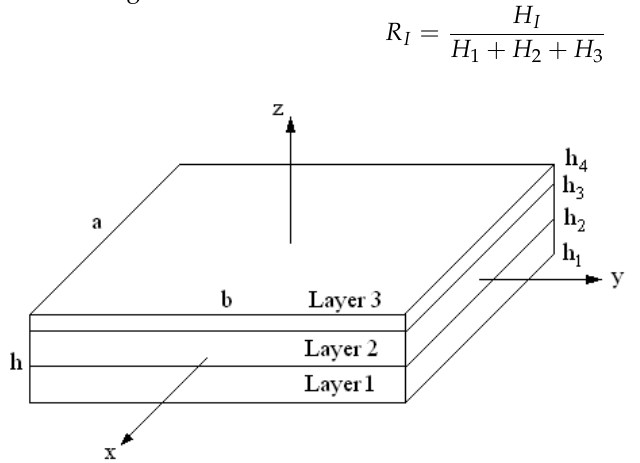
Figure 1. Geometry and dimensions of a non-symmetric, rectangular FG sandwich plate with uni- form thickness.